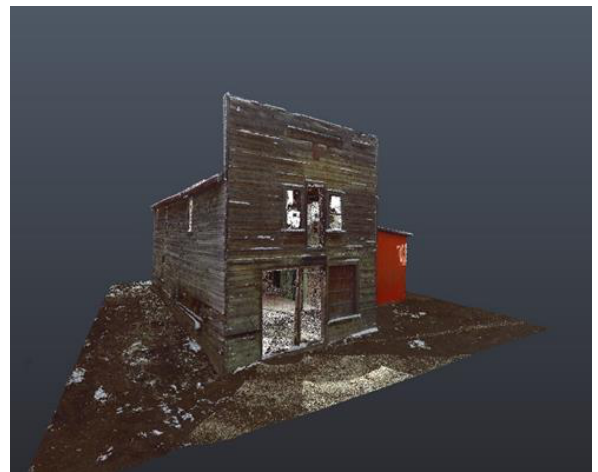
Figure 7: The completed 3D model of the laundry shop. Source: Peter Dawson